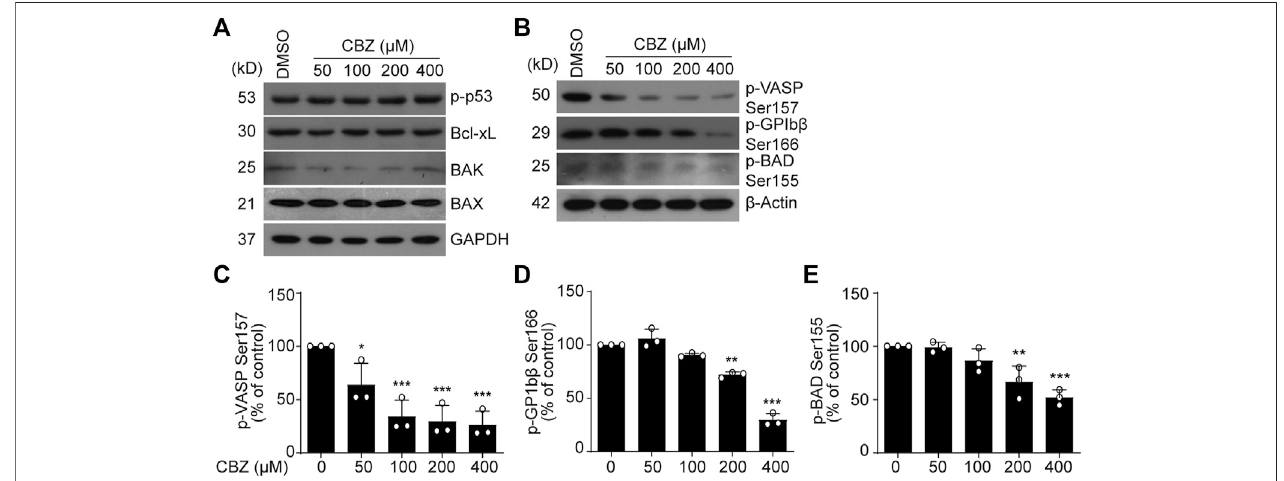
FIGURE 2 | PKA activity isreduced in CBZ treated platelet. (A,B) Washed human platelets were incubated with indicated concentrations of CBZ or vehiclecontrol at 37 ° C for 70 H. Indicated proteins were analyzed with various primary antibodies by Western blot in human platelets. Data are representative of three